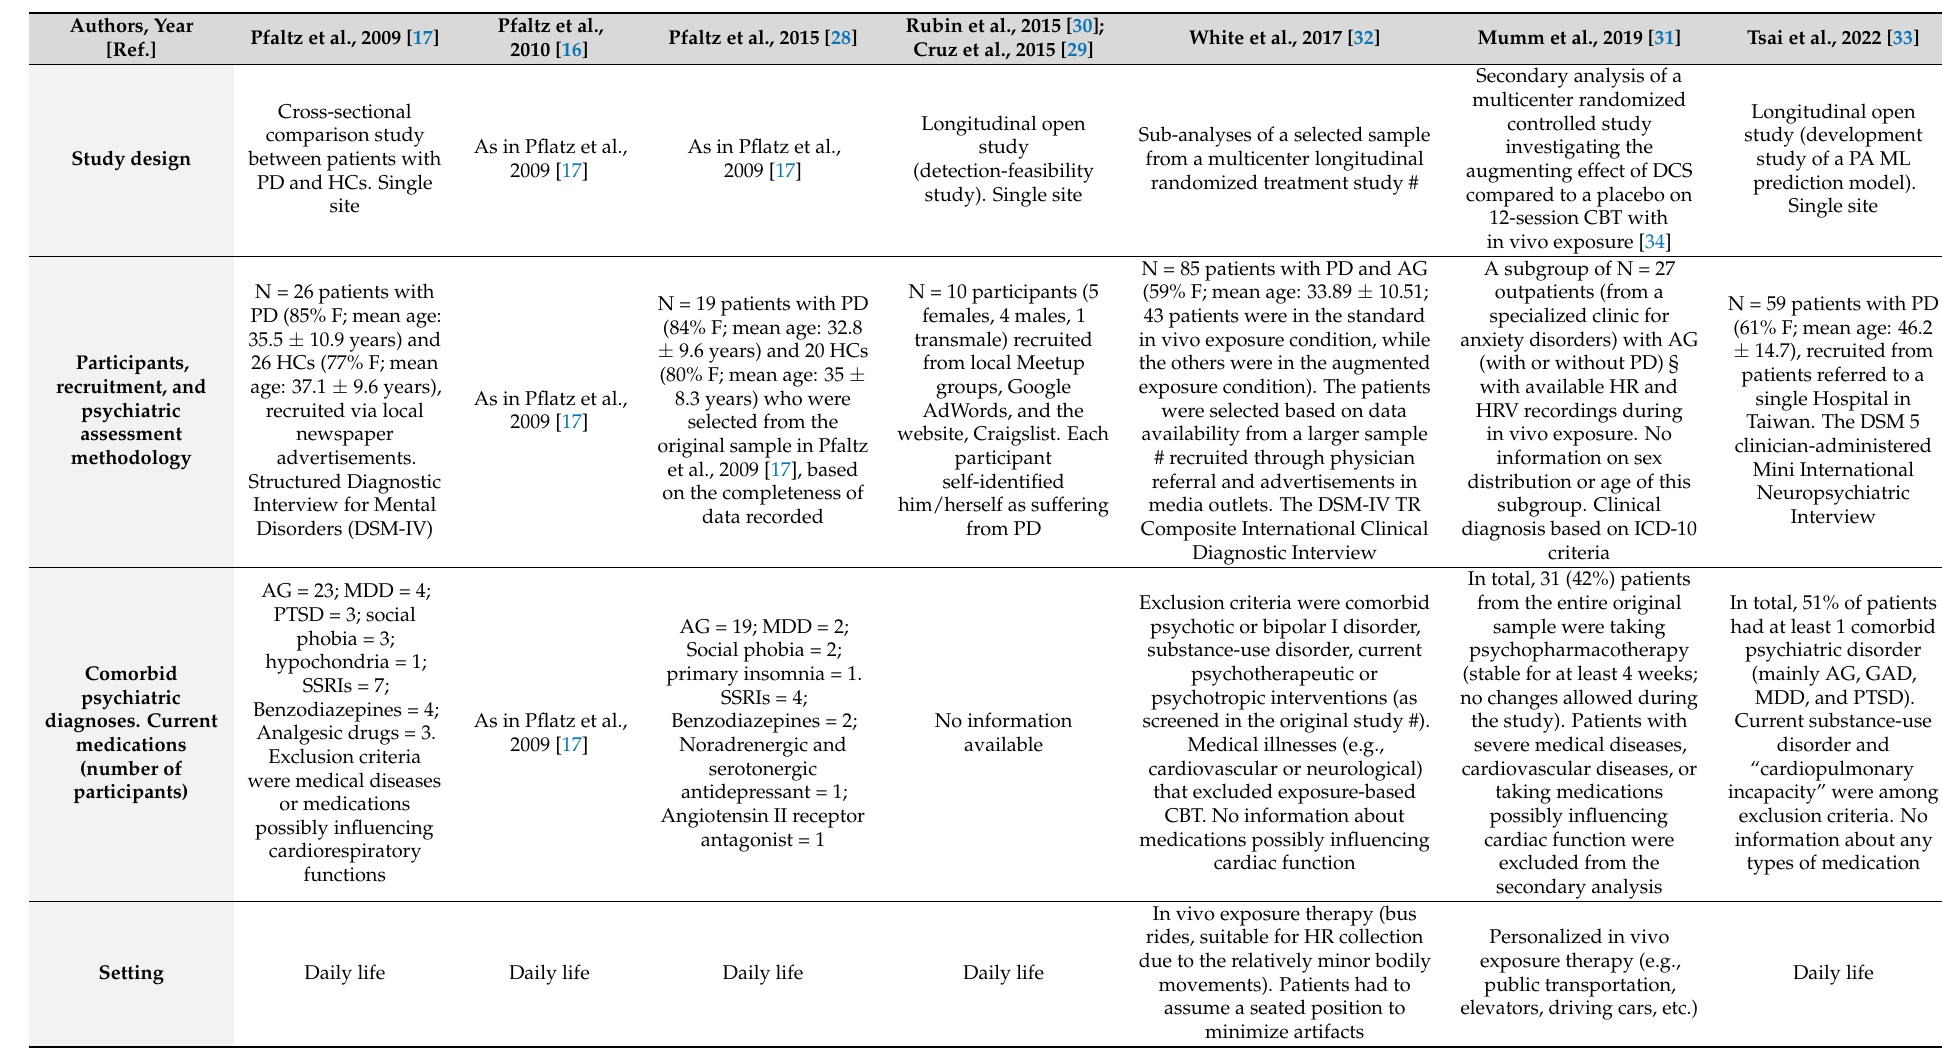
Table 1. Details of the selected